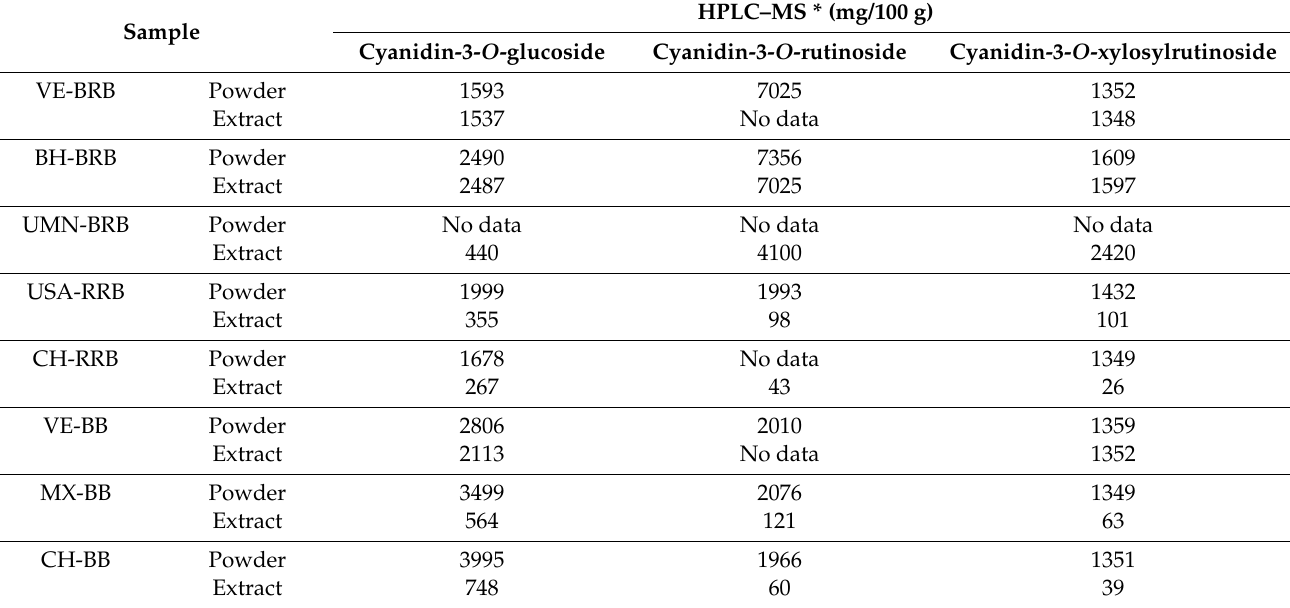
Table 2. Anthocyanin composition within powdered berries and berry extracts determined by